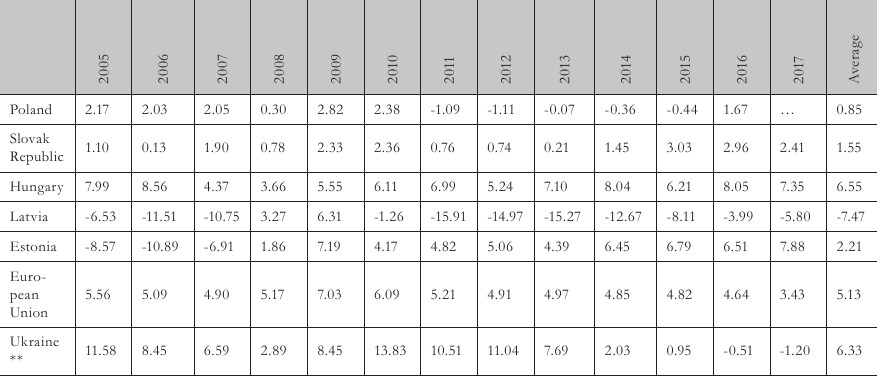
Tab. 1. – Household savings by countries, % of household disposable